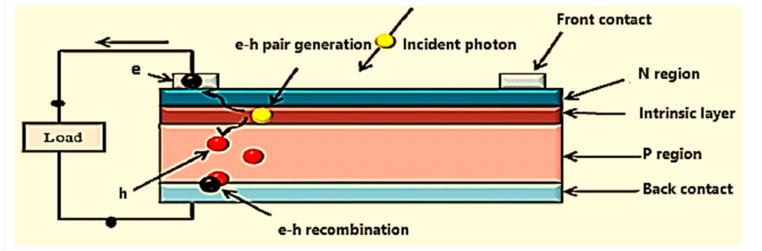
Figure 1. A p-n junction PV